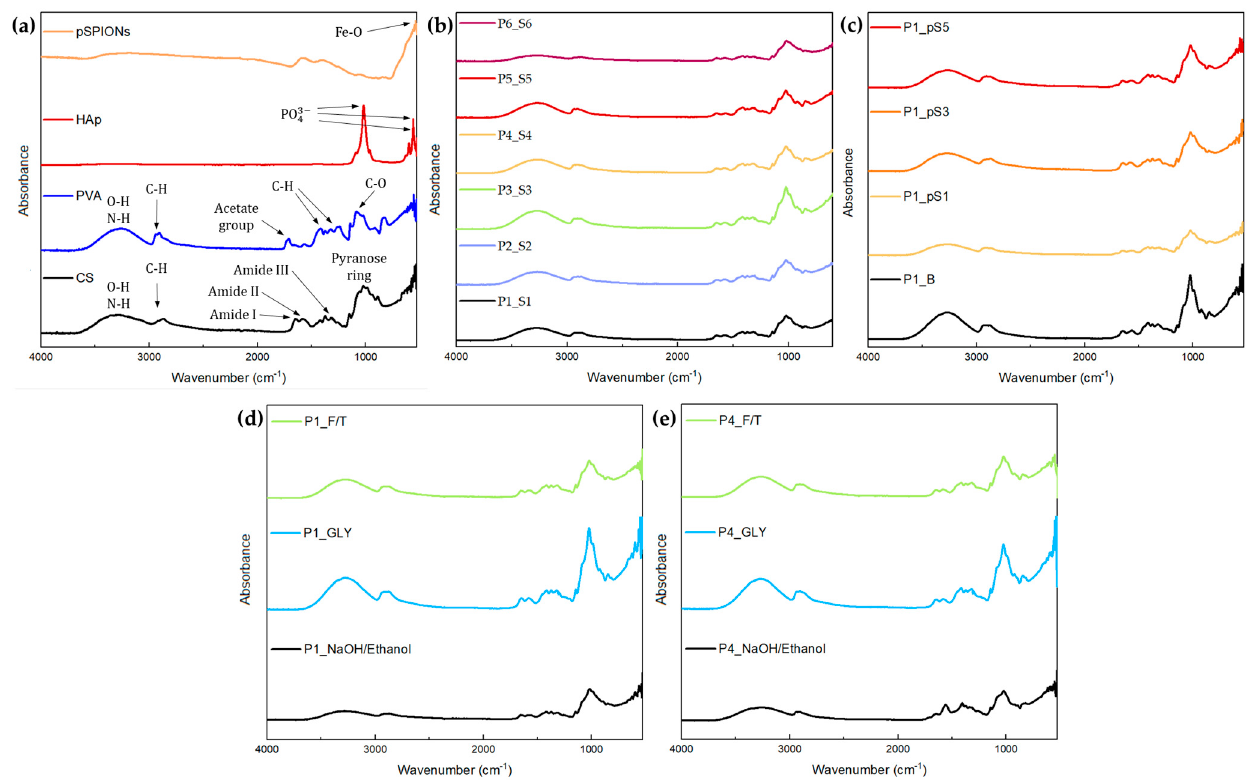
Figure 3. FTIR spectra: ( a ) pure CS (black), pure PVA (blue), pure HA (red), and pristine pSPIONs (orange); ( b ) P1_S1 (black), P1_S2 (blue), P1_S3 (green), P1_S4 (yellow), P1_S5 (red), P1_S6 (purple); ( c ) P1_B (black), P1_pS1 (yellow), P1_pS3 (orange), P1_pS5 (red). ( d ) FTIR spectra of P1_S1 at different moments in the post printing stage: Freeze dried scaffold after the NaOH/Ethanol solution (black); Freeze dried scaffold after the GLY bath and soaking in ethanol (blue); Freeze dried scaffold after undergoing 3 F/T cycles (green). ( e ) FTIR spectra of P4_S4 at different moments in the post printing stage: Freeze dried scaffold after the NaOH/Ethanol solution (black); Freeze dried scaffold after the GLY bath and soaking in ethanol (blue); Freeze dried scaffold after undergoing 3 F/T cycles (green).